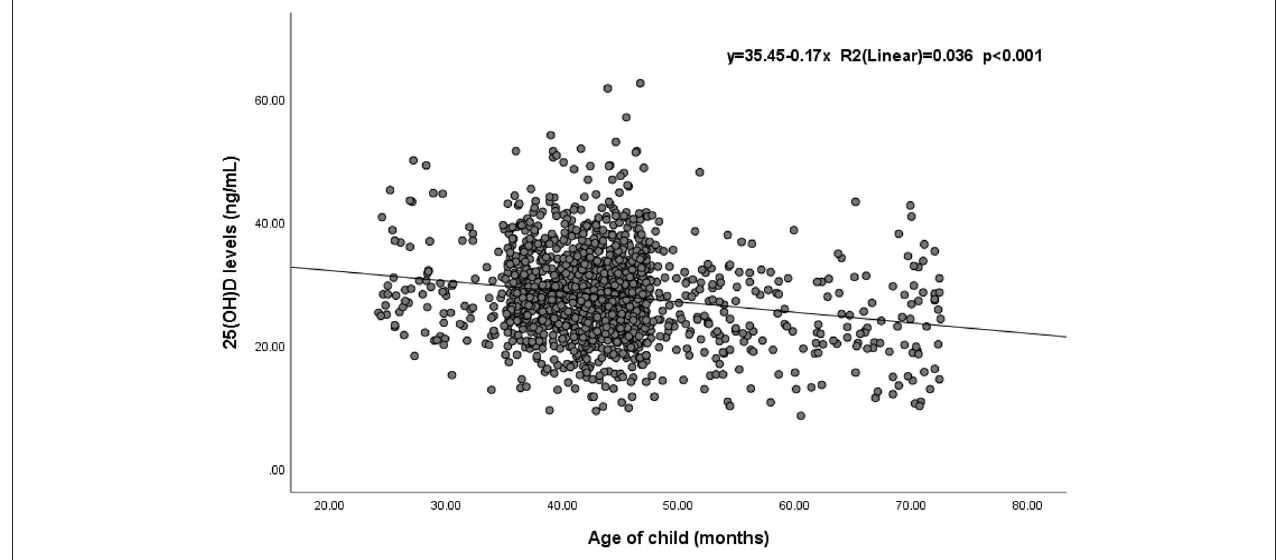
FIGURE 1 | The effect of age on 25(OH)D levels in children ( n =